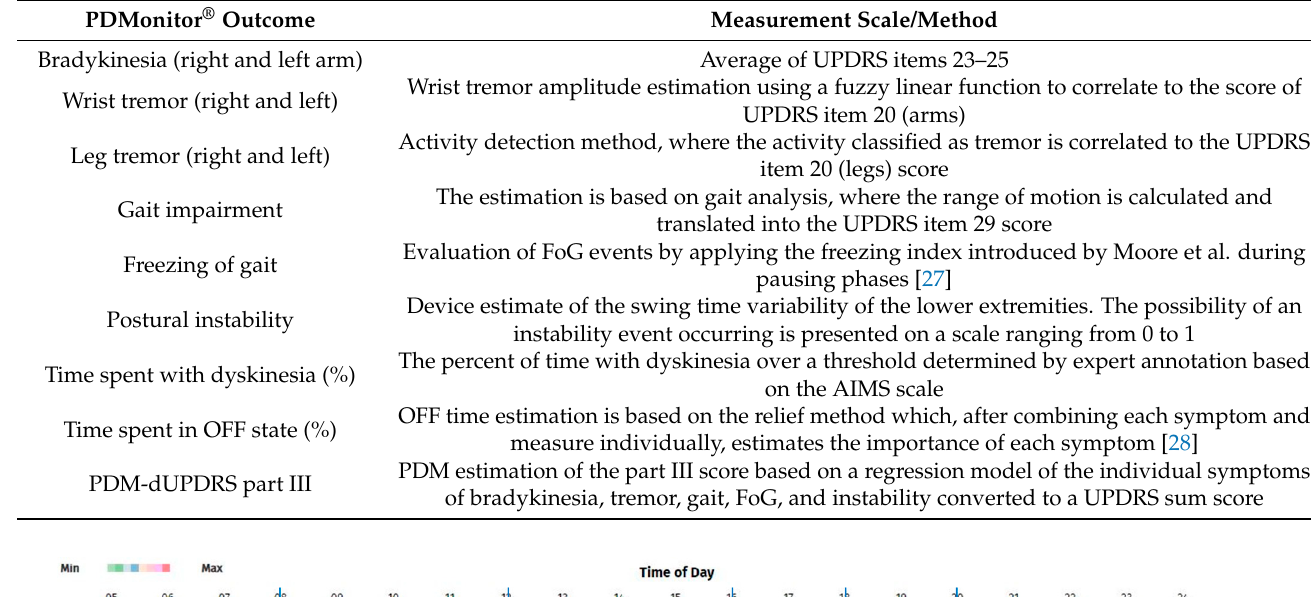
Table 2. PDMonitor ® outcomes and the respected measurement scales correlated and methods followed.